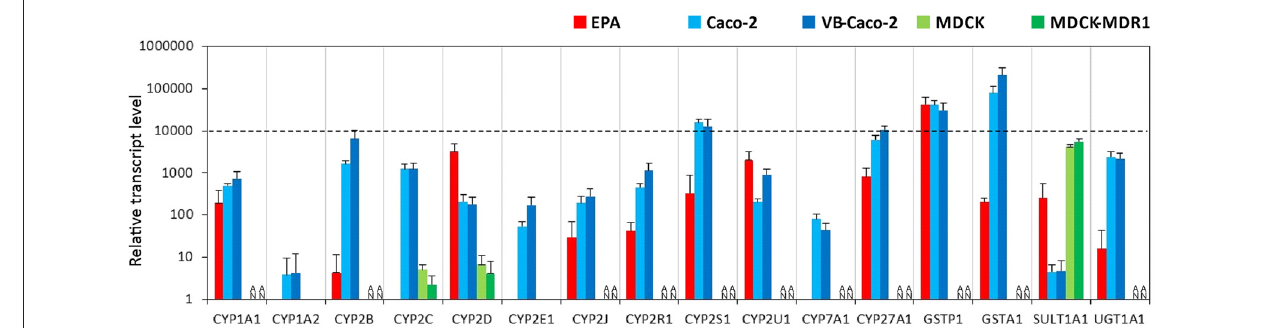
Frontiers in Molecular Neuroscience |